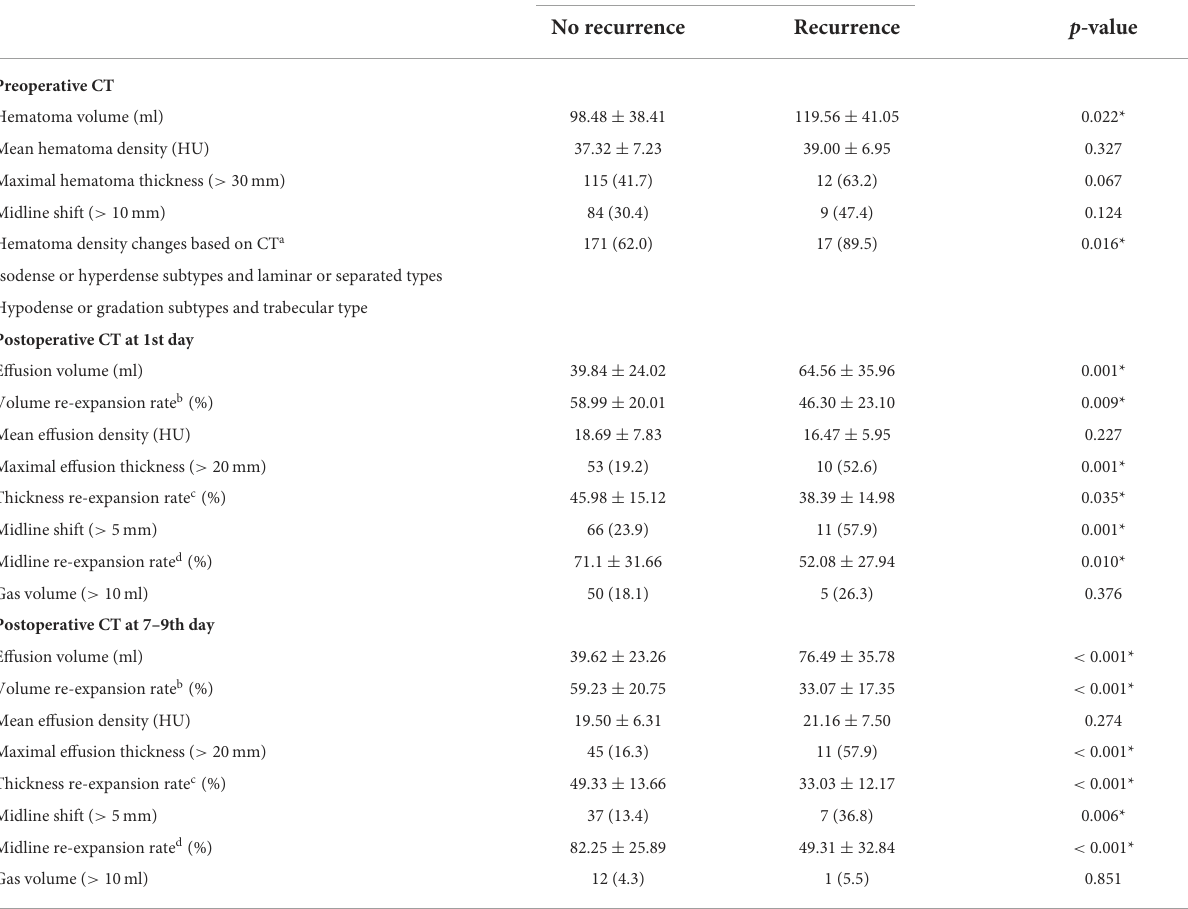
TABLE 2 Imaging characteristics of patients with CSDH ( n =